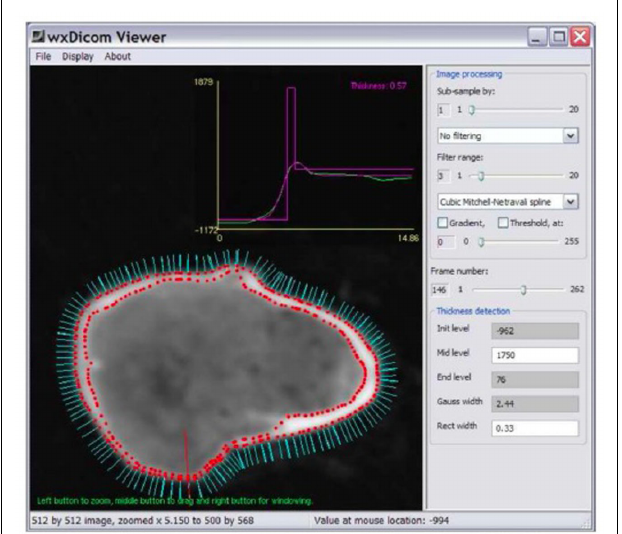
FIGURE 7 | Cadaveric high-resolution CT image across the femoral head–neck junction showing the trabecular bone network centrally and the distinctive pattern of cortical–trabecular–cortical bone in marginal osteophytes at the inferior aspect (arrowheads). Image by Dr Paul Mayhew, from a Densiscan 1000 peripheral Quantitative CT Scanner, Scanco AG Switzerland. Specimen courtesy of Professor John Clement, Melbourne Femur collection (Melbourne Dental School, Australia).